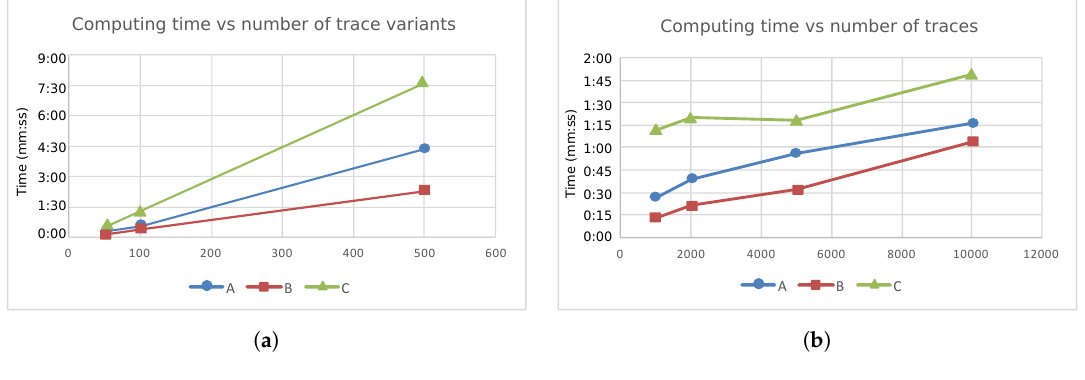
Figure 18. Performance of the greedy strategy when varying the log complexity. ( a ) Trace variants’ complexity; ( b ) trace repetitions’